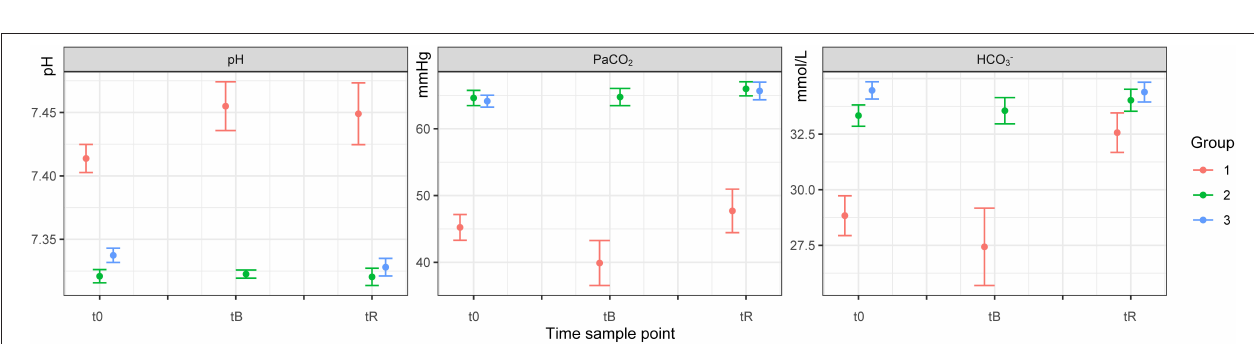
FIGURE 1 | Blood pH, PaCO 2 and HCO 3 − of white rhinoceroses ( Ceratotherium simum simum ) per group: Group 1, free-ranging ( n = 14), immobilized with ≈ 2.5 µ g/kg etorphine (high dose), ≈ 2.5 µ g/kg medetomidine, ≈ 25 µ g/kg midazolam and 1,500–1,700 IU hyaluronidase; Group 2, game-farmed ( n = 28), immobilized with ≈ 2.5 µ g/kg etorphine (high dose), ≈ 2.5 µ g/kg medetomidine, ≈ 25 µ g/kg midazolam and 1,500–1,700 IU hyaluronidase and Group 3, game-farmed animals ( n = 20) ≈ 1 µ g/kg etorphine (low dose), ≈ 5 µ g/kg medetomidine and ≈ 25 µ g/kg midazolam. Time sampling points: t0) at first handling, t B ) after butorphanol administration and t R ) at reversal. Data presented as Median (range).